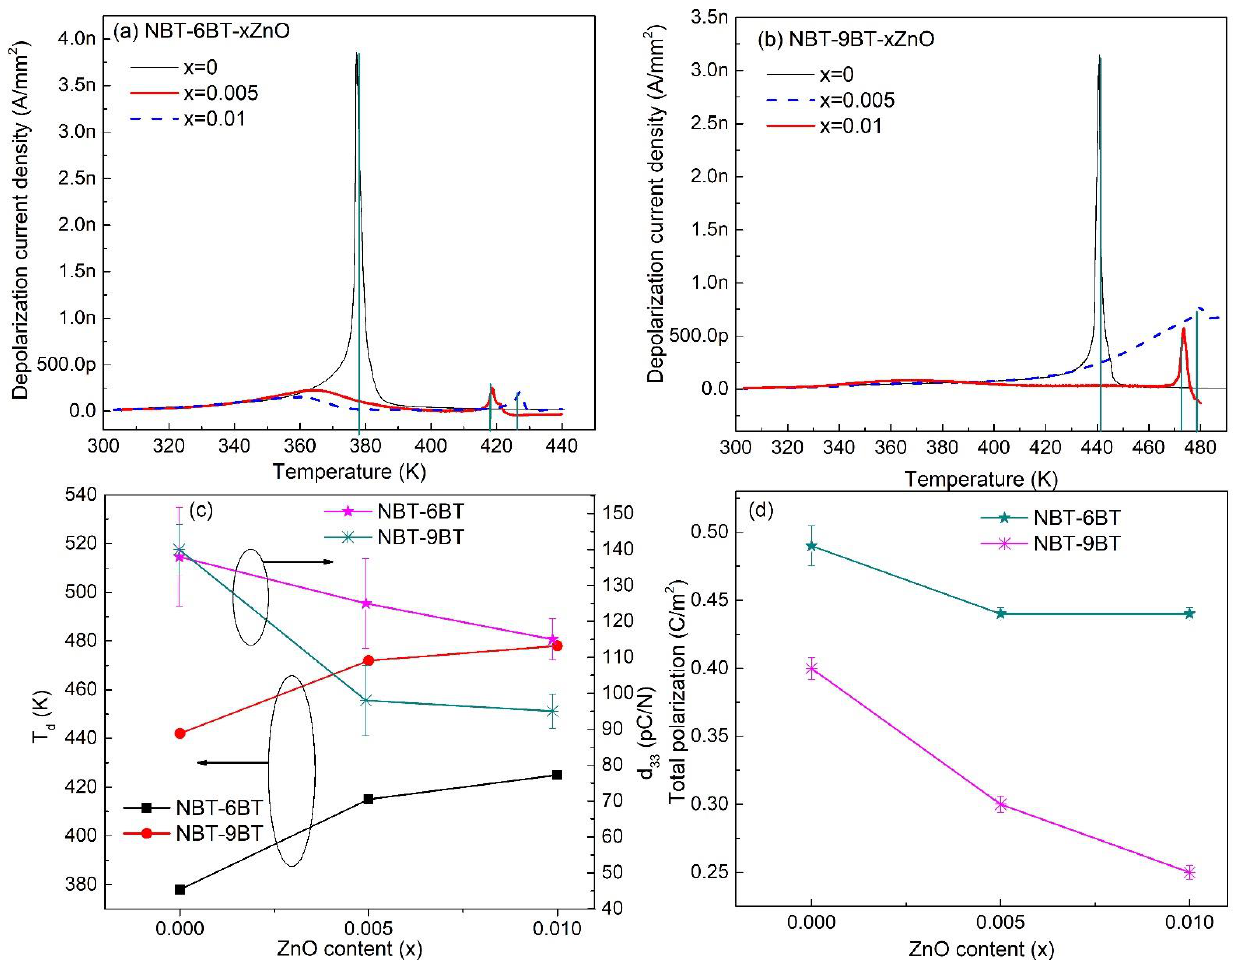
Figure 3. Depolarization current density after one complete cycle as a function of temperature for ( a ) NBT-6BT-xZn (x = 0, 0.005, 0.01) and ( b ) NBT-9BT-xZn (x = 0, 0.005, 0.01). The vertical green lines denote the T d . ( c ) Depolarization temperature (T d ) and piezoelectric coefficient (d 33 ) of NBT-yBT (y = 6, 9) as a function of ZnO content. ( d ) Total polarization of NBT-yBT (y = 6, 9) as a function of ZnO content.